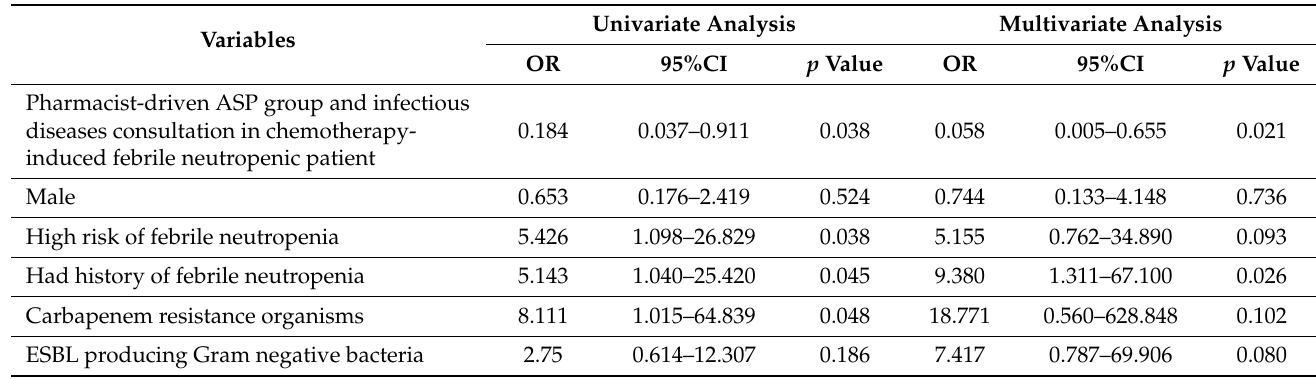
Table 3. Multivariate analysis of 30-day infectious diseases-related